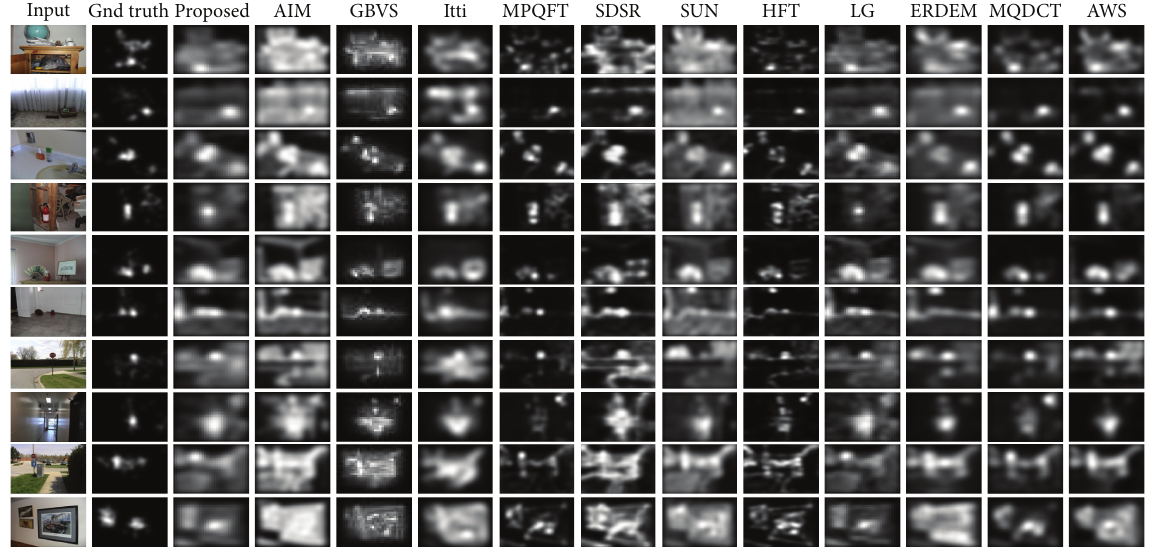
Figure 9: Comparison of our method with other state-of-the-art saliency models. The first column is the input image with second column being ground truth followed by our proposed saliency model. Results from all the other models are plotted in the same row.